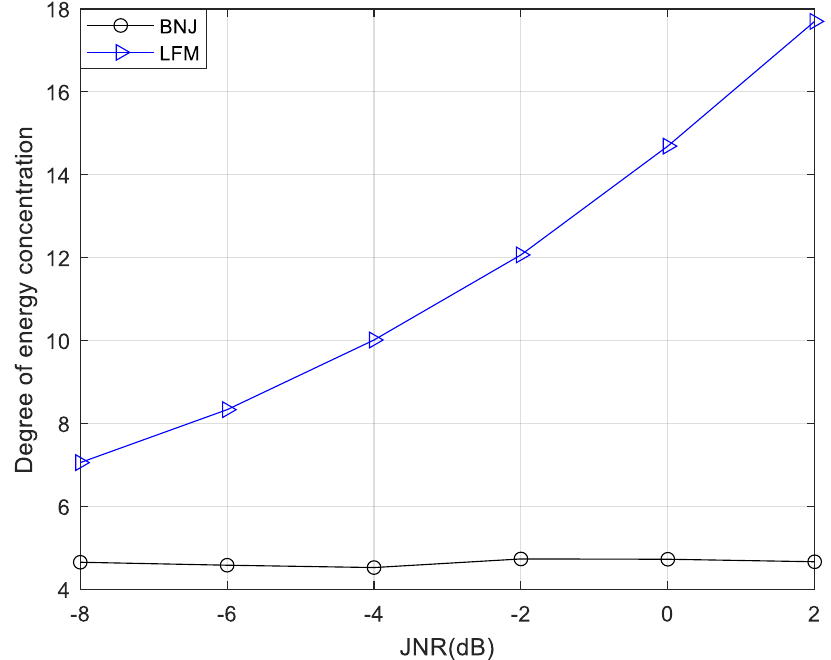
Figure 3. Changes of broadband noise jamming (BNJ) and linear frequency modulation jamming (LFM) as JNR increases.